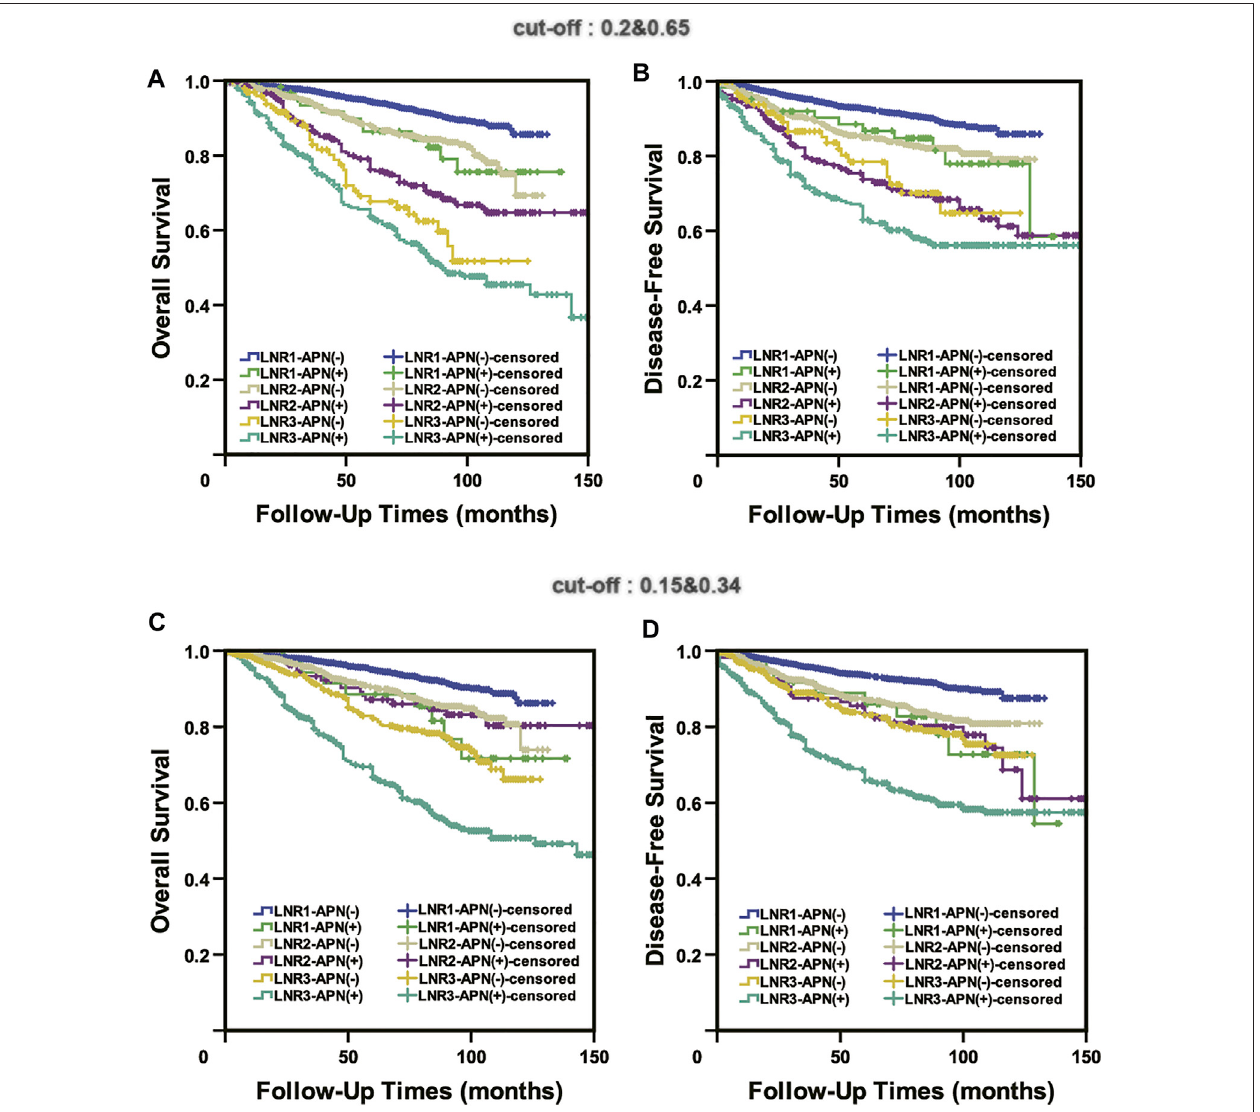
FIGURE 6 | Neither the published cut-off values (0.2 and 0.65) (A,B) nor our cut-off values (0.15 and 0.34) (C,D) could accurately predict the prognosis of APN(+) patients.